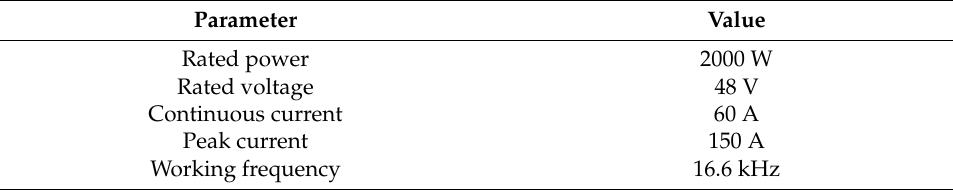
Table 6. Parameters of PMSM Driver.